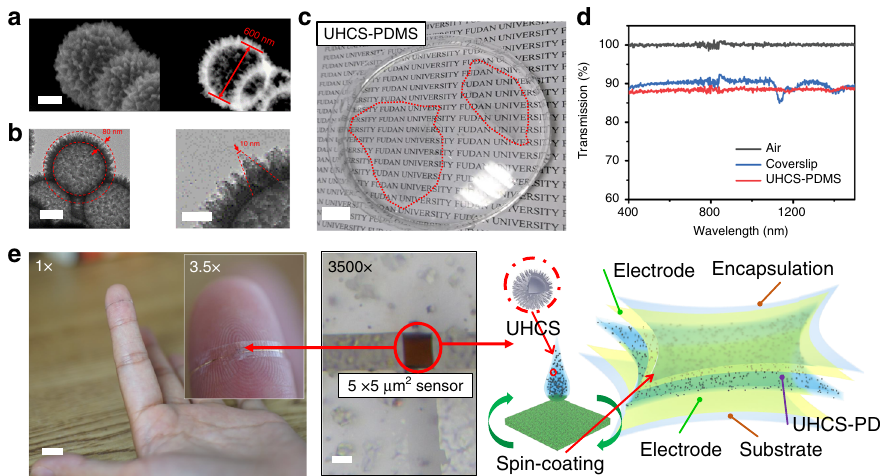
Fig. 1 Fabrication and characterization of the thin- fi lm sensor. a Typical scanning transmission electron microscopy (STEM) images showing the UHCSs and the thickness of the shell. Scale bar: 250 nm. b Typical transmission electron microscopy (TEM) images showing the spine length and the tip diameter of the sphere. Scale bars: 200 and 60 nm. c Photo of the peeled-off thin fi lm in a petri dish. Scale bar: 15 mm. d Light transmittance from 400 to 1500 nm. e Optical photography of the urchin-like hollow carbon sphere polydimethylsiloxane fi lm (UHCS-PDMS) pressure sensor on a fi ngertip and three- dimensional scheme of the tiny sensor. Scale bars: 10 mm and 3 μ